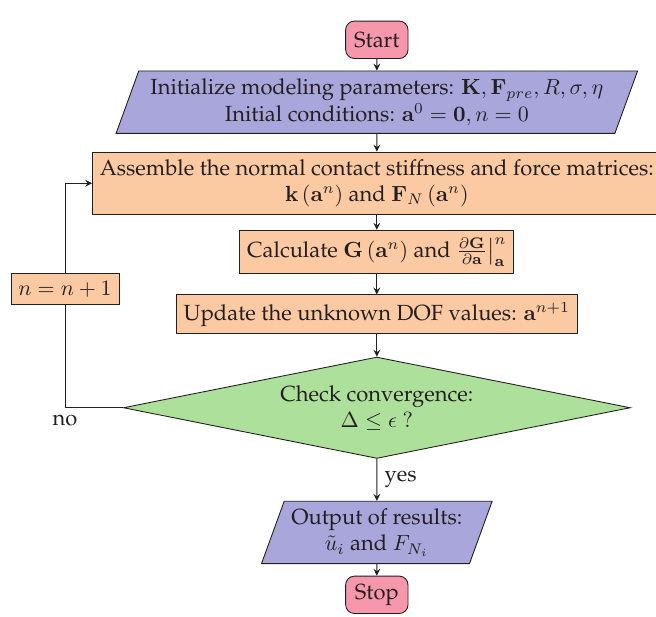
Figure 5. Flowchart of the static contact